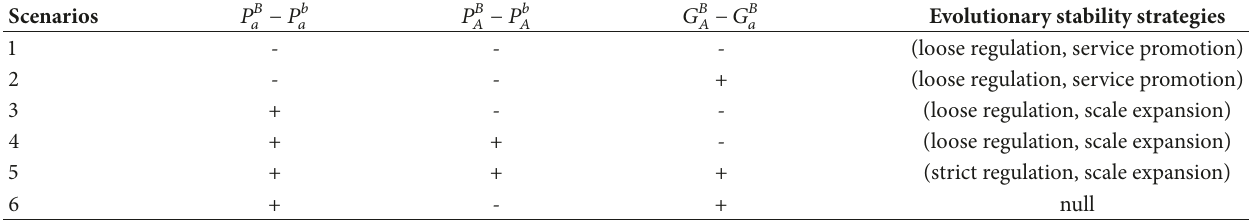
Table 7: Evolutionary stability strategies under different